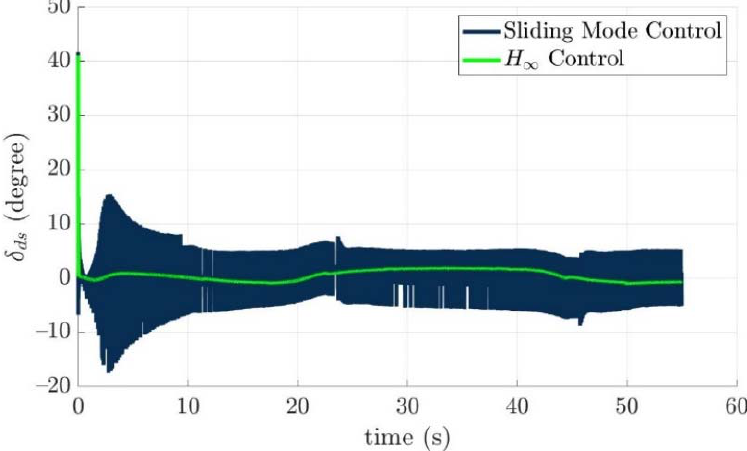
Figure 24. The downward stern rudder angles of the controlled torpedo-like underwater vehicle for two control laws, respectively.